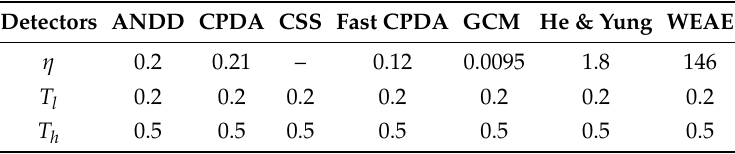
Table 3. Parameter settings of the compared corner detectors.